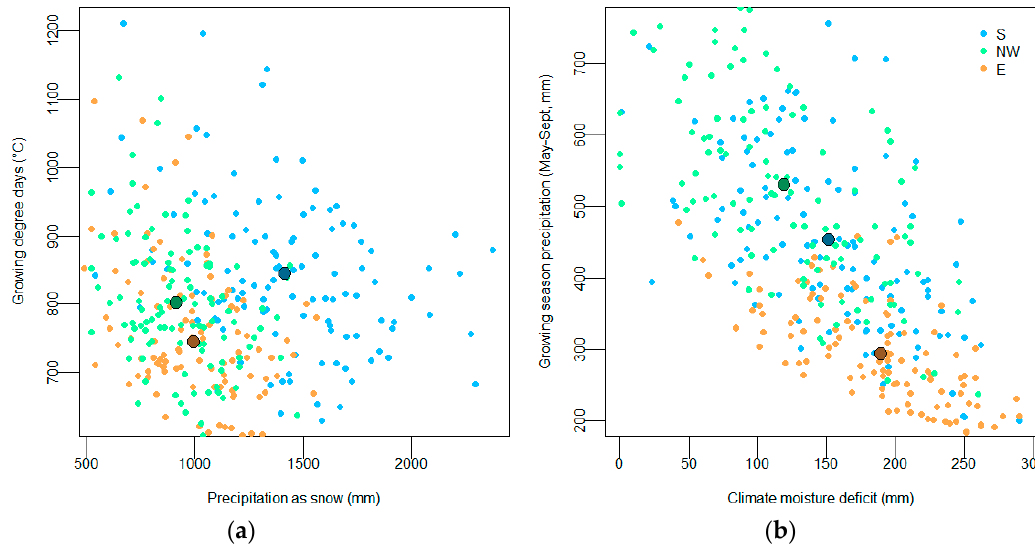
Figure 2. Annual climate variability since 1901 (small points) and long-term mean climate (large points) for the three sub-alpine sampling locations on Mt. Rainier. Selected climate variables: precipitation as snow and growing degree days ( a ) and climate moisture deficit and growing season precipitation ( b ) for comparison among the three sites. Climate data obtained from ClimateWNA (Version 5.40, University of British Columbia, BC, Canada) spans from 1901 to 2015. Growing degree days, precipitation as snow, and climate moisture deficit are derived annual summaries of monthly variables calculated by ClimateWNA. The data for the south side is for the long-term forest demographic monitoring site on that side of the mountain (1603 m).